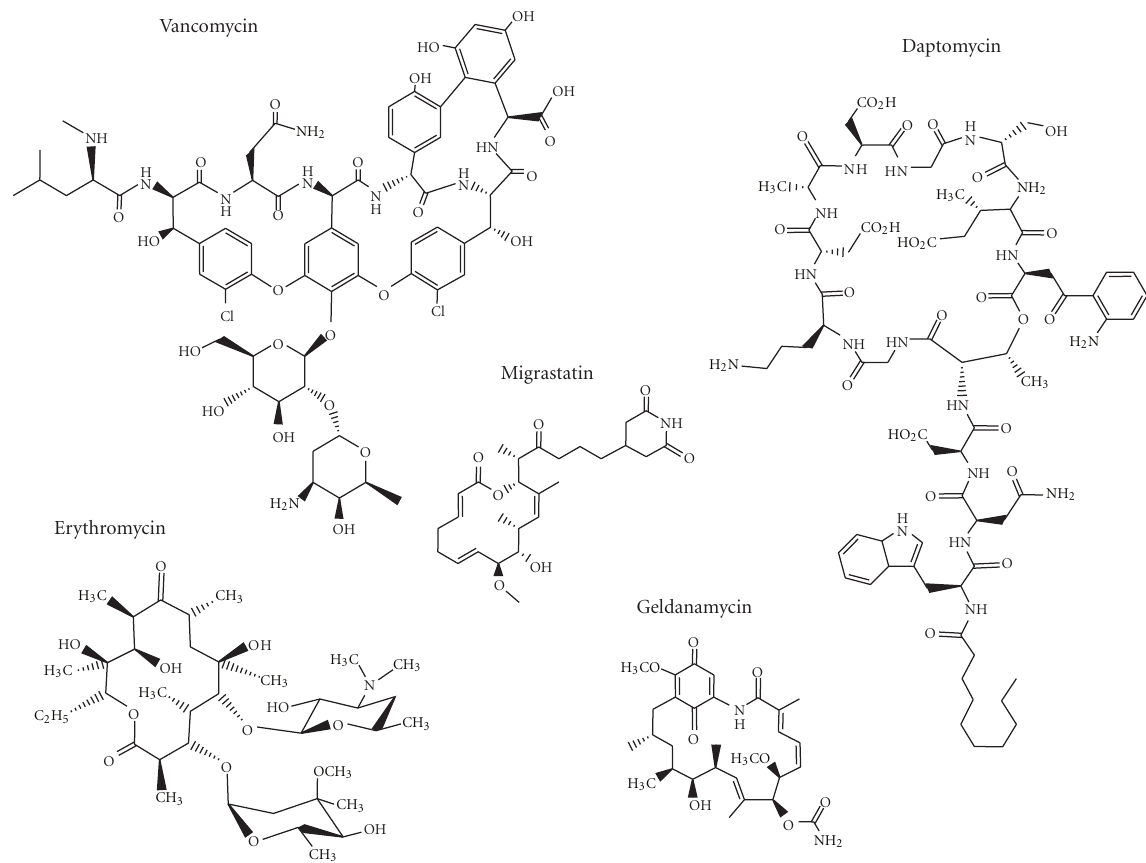
Figure 1: Examples of natural compounds produced by actinomycetes. Vancomycin and daptomycin are synthesized by NRPSs from Amycolatopsis orientalis and Streptomyces roseosporus , respectively; erythromycin, migrastatin, and meridamycin are produced by PKSs in Saccharopolyspora erythraea , Streptomyces platensis, and Streptomyces sp. NRRL 30748